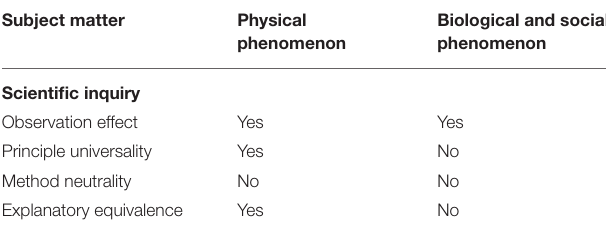
TABLE 3 | Properties of different